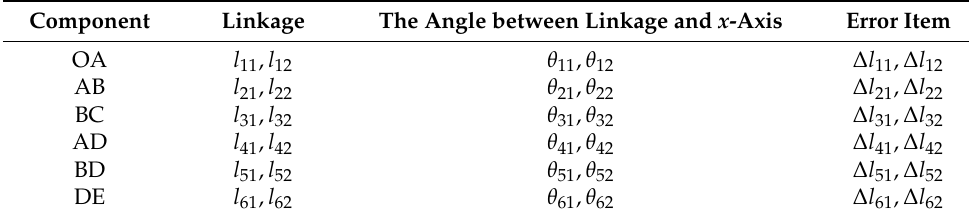
Table 1. Linkage length error of press transmission mechanism.